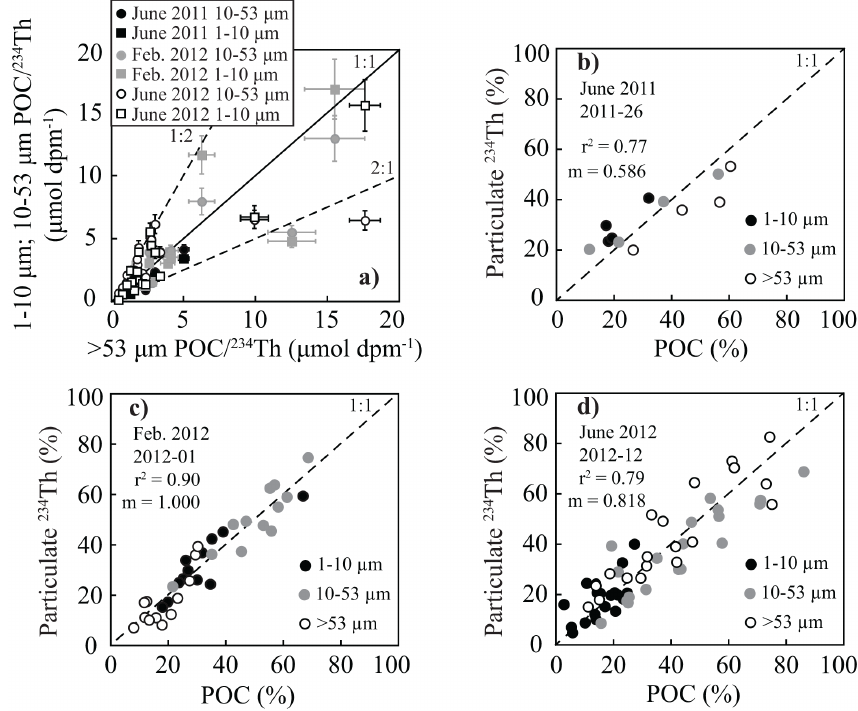
Figure 4. (a) POC / 234 Th ratios on 1–10µm particles and on 10–53µm particles plotted against the POC / 234 Th ratio on > 53µm particles. Fractional distributions of POC and particulate 234 Th are plotted for three size classes of particles. The percentage of total POC associated with each size class is plotted against the percentage of total particulate 234 Th for samples collected at stations on Line P during (b) June 2011, (c) February 2012, and (d) June 2012. The correlation coefficient ( r 2 ) and the slope of the linear regression ( m ) are shown for each